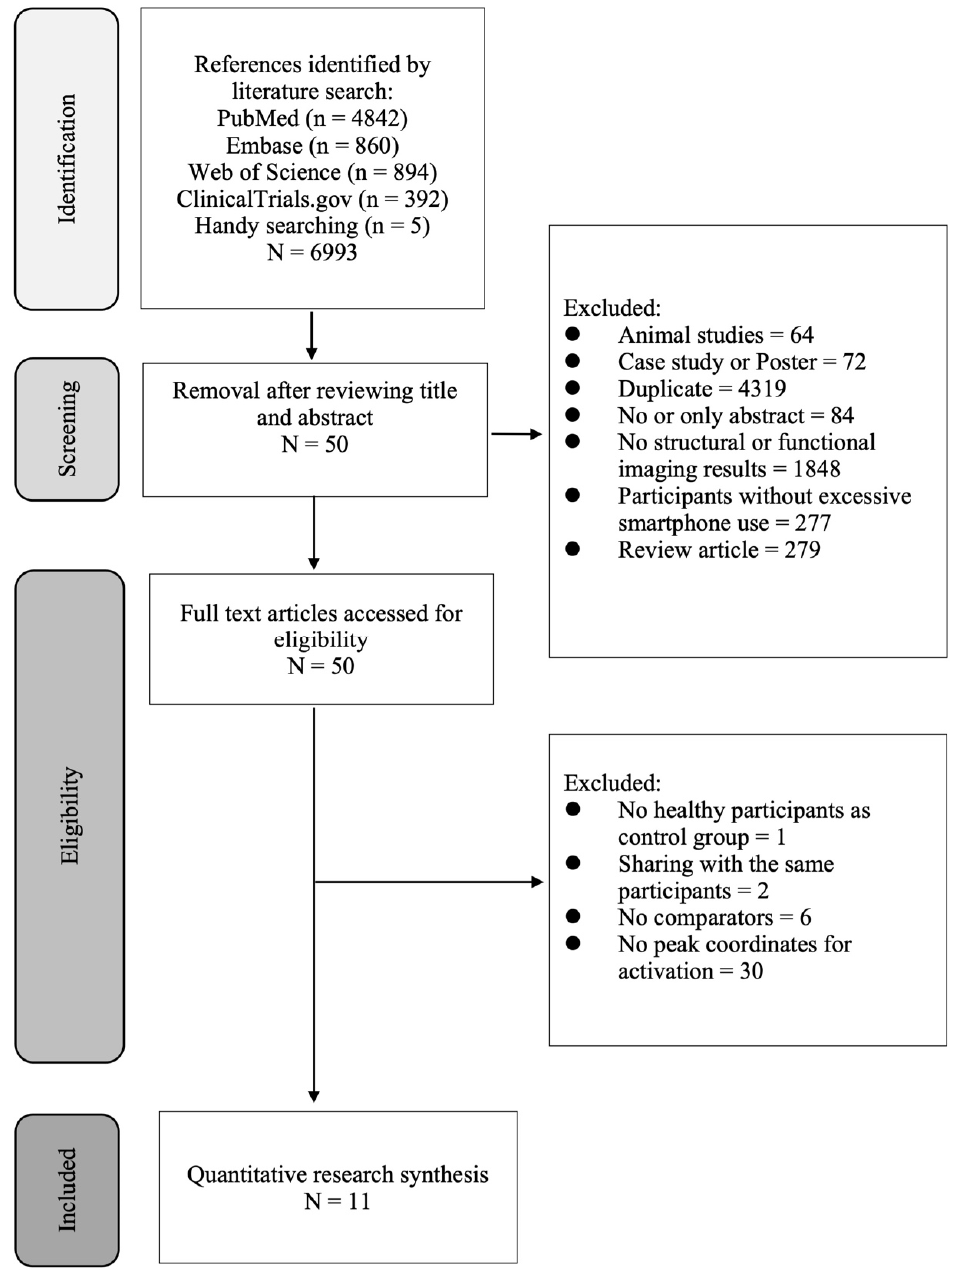
Figure 1. Flowchart summarizing the process of study selection. Of the 11 included articles, seven compared the brain volumes between individ- uals with excessive smartphone use ( n = 165) and their comparators with regular use ( n = 256) (Table 1). The mean age of the participants was 19.61 years (range, 15.26 to 29.80 years) with a female prevalence of 52.53% (range, 25.56.7 to 68.18%) (Table 1). With reference to brain activations, six studies investigated the functional connectivity of in- dividuals with excessive smartphone use ( n = 139, mean age = 24.18 years) and their counterparts with regular use ( n = 137, mean age = 24.47 years) based on ALE analy- ses of their fMRI findings (Table 1). Because excessive smartphone use was found to be associated with activations of certain brain regions but decreased activities in others, data were collected from four studies that provided information about the regions with enhanced activities among excessive users compared to regular users (176